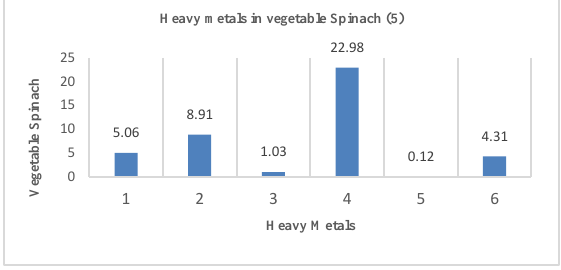
Figure 18: Average Concentration in vegetable